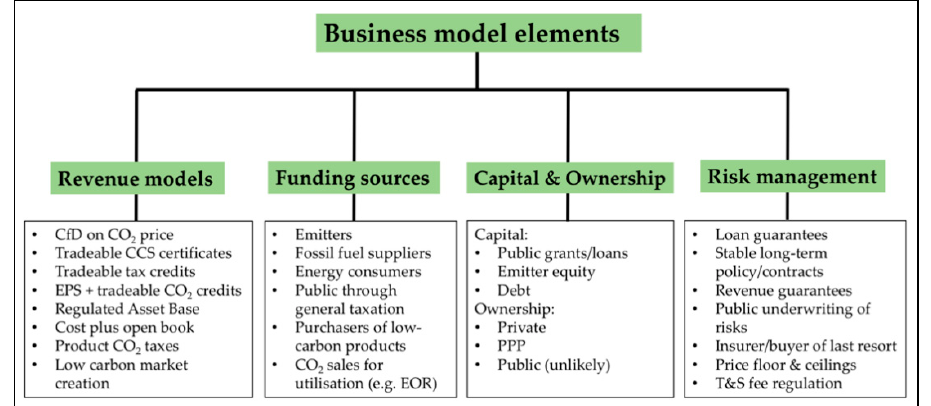
Figure 11. Elements of a CCUS business model.